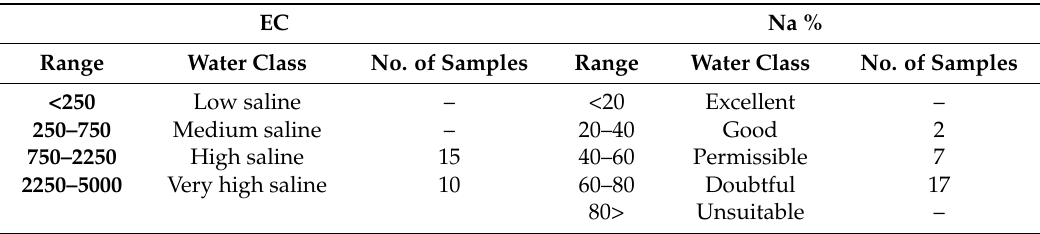
Table 7. Analysis of (EC) and (Na %) on the basis of water class [44].